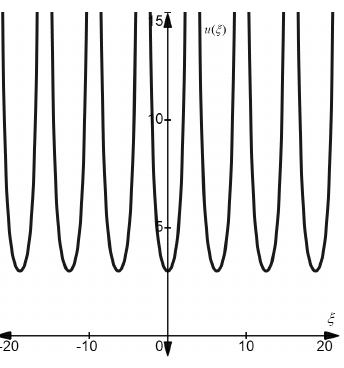
Figure 5. The periodic wave solution when v = 2, β = − 3, γ = 1, and α = 1. Finite difference